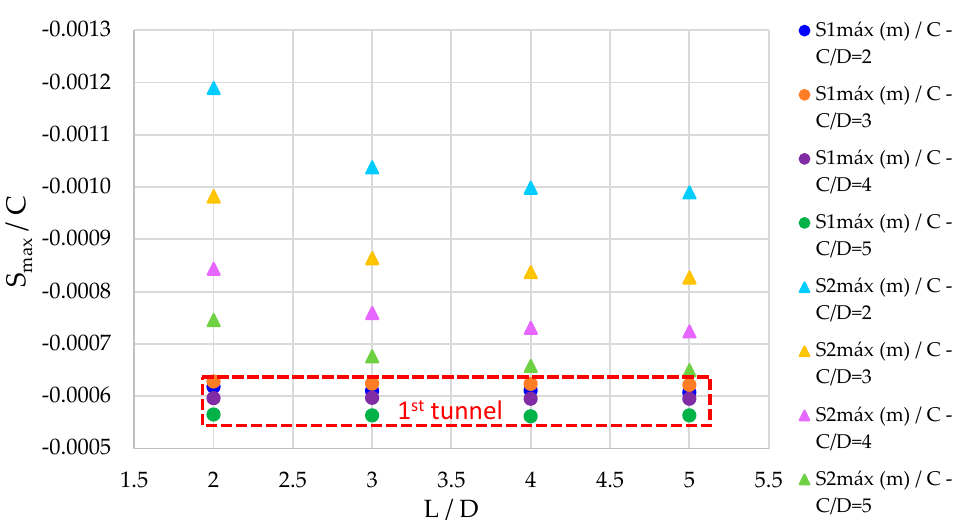
Table 3. Numerical analyses of maximum settlement.